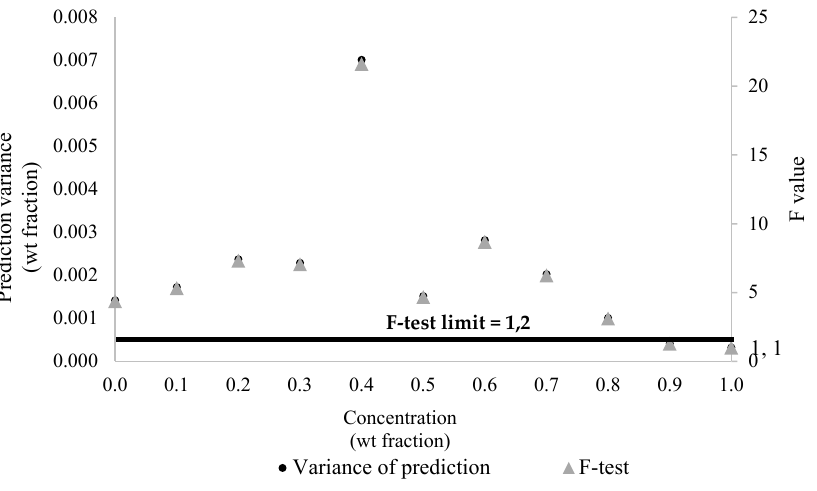
Figure 10. Error performance for H-PCR at 90 °C and 450 rpm for different concentrations.